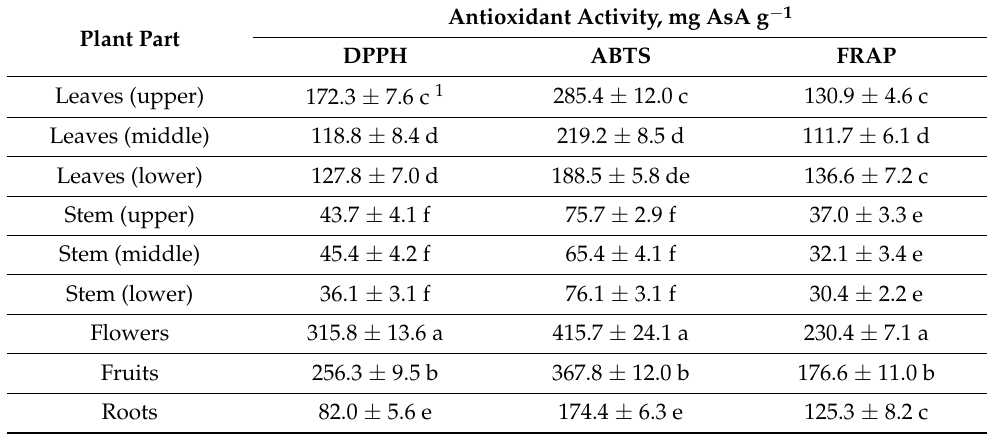
Table 3. Antioxidant activity of the extracts from different parts of meadowsweet.